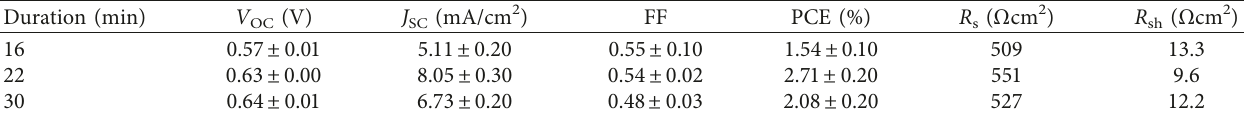
Figure 3: Effect of HA washing duration on the device performance parameters. Table 1: Summary of the device performance based on HA washing treatment duration.